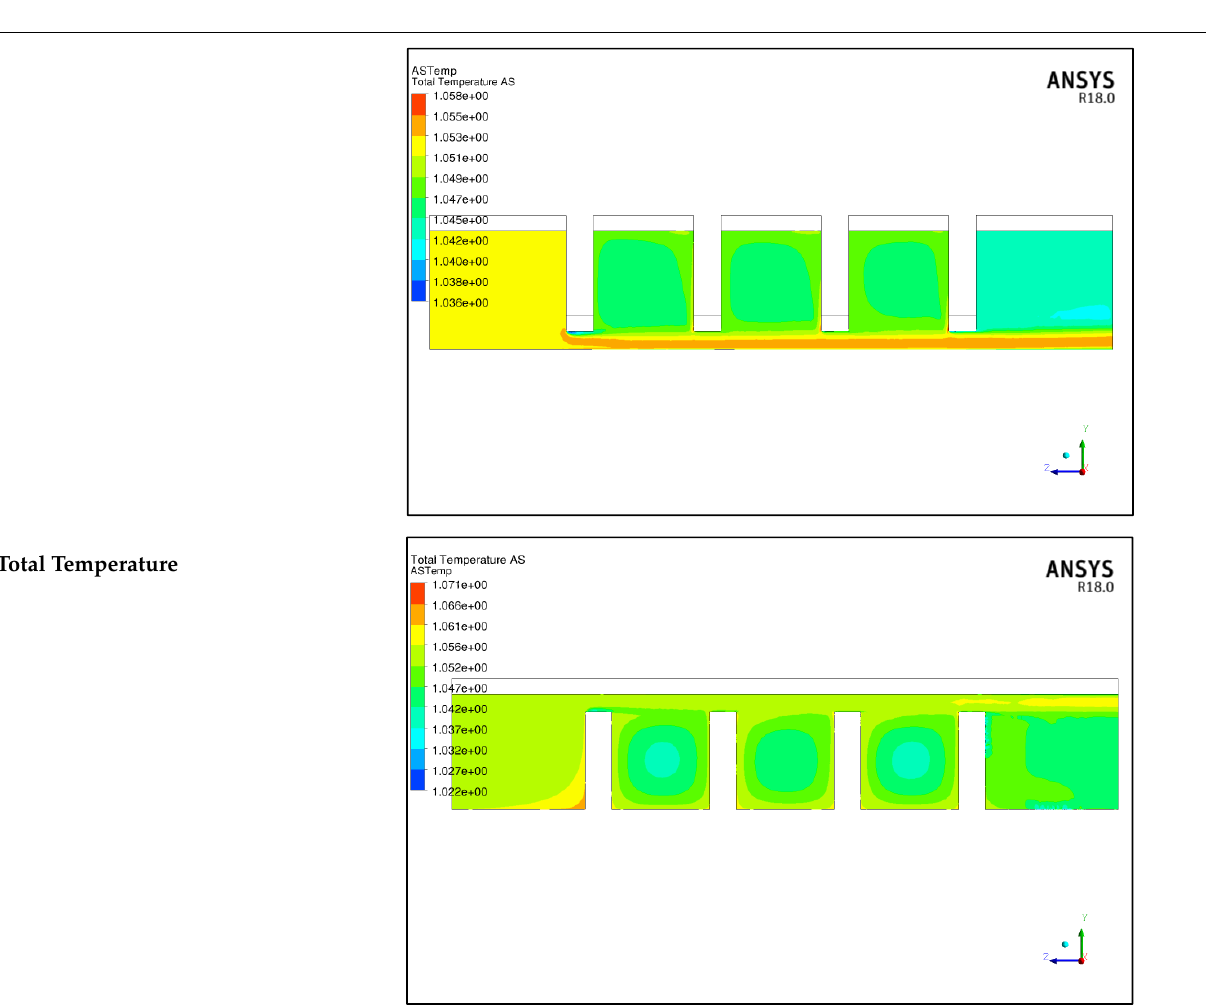
Table A4. Static pressure